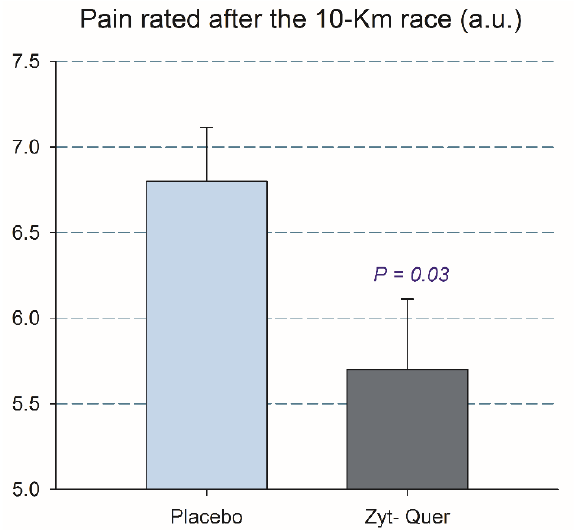
Figure 1. Pain reported at a 90° angle of knee flexion 30 s after arrival from the 10 km race. The error bars represent the standard error of the mean. Placebo, N = 23; polyphenols, N = 25.